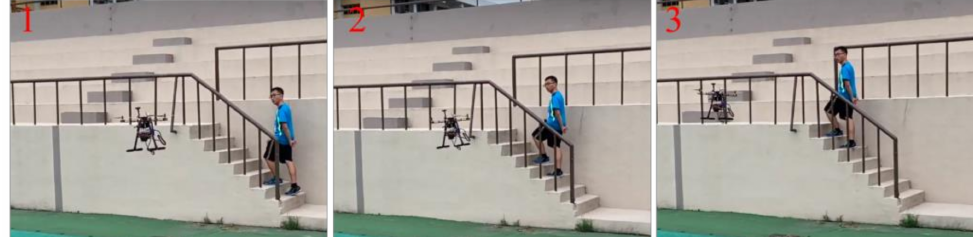
Figure 22. UAV tracking target test on stairs (The sequence of target movement and UAV tracking is shown in 1 – 3